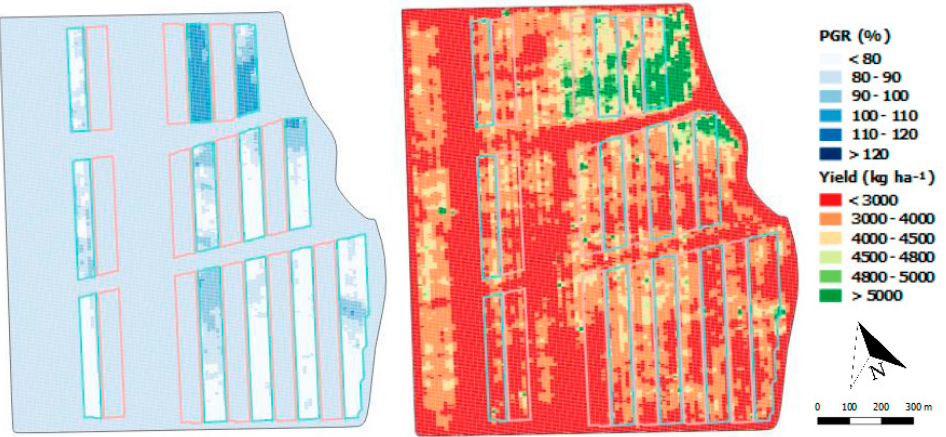
Figure 11. Spatial distribution of applied plant growth regulators and cottonseed yield in conventional row spacing cotton in field CF3.